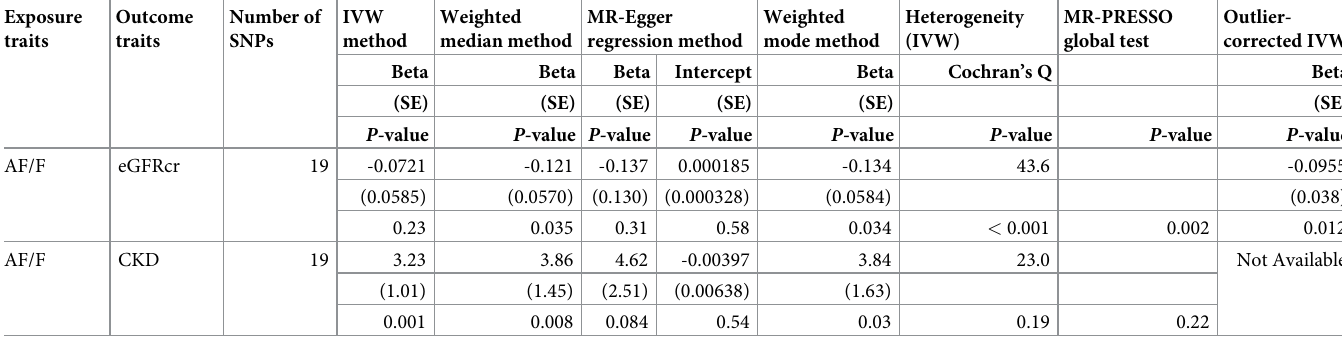
Table 1. MR results of the effects of AF/F on the change of eGFRcr and the risk of CKD. Exposure Outcome Number of traits traits